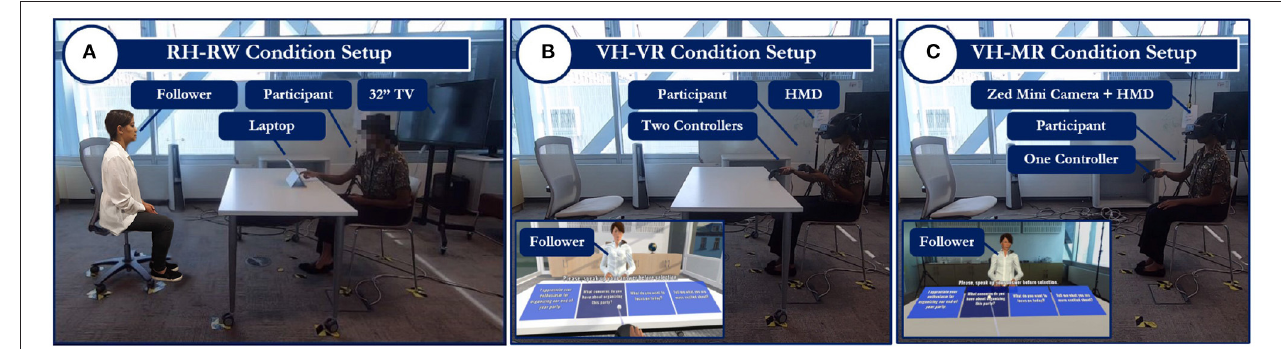
FIGURE 6 | The setups of our three conditions. (A) RH-RW condition, (B) VH-VR condition, and (C) VH-MR